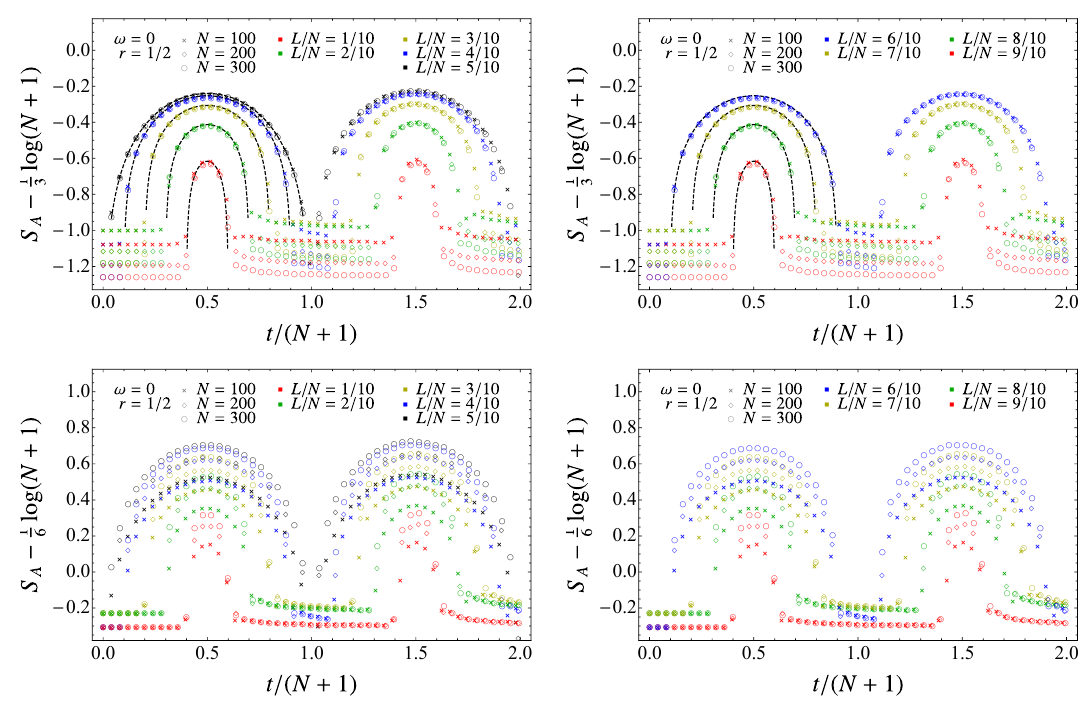
Figure 7 . Temporal evolution of the entanglement entropy S A in the same setup described for figure 6. The size of the blocks is L 6 Nr in the left panels and L > Nr in the right panels. The black dashed curves in the top panels correspond to